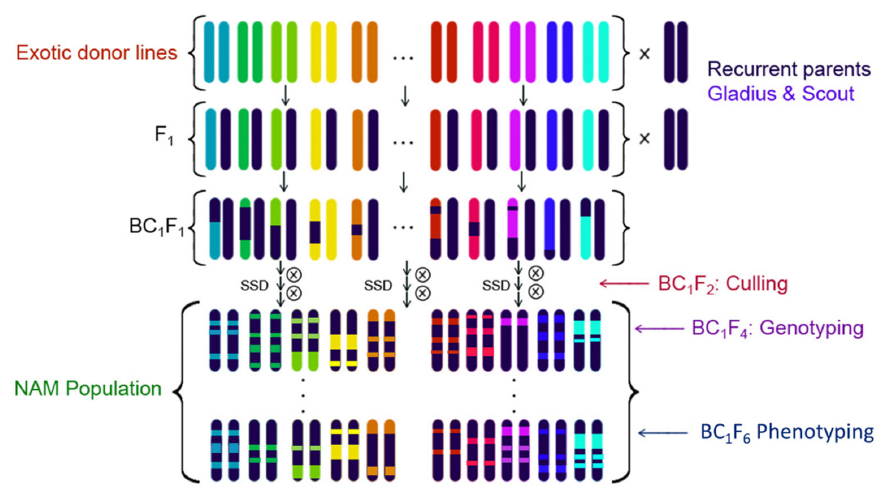
Figure 6. Crossing design for the development of